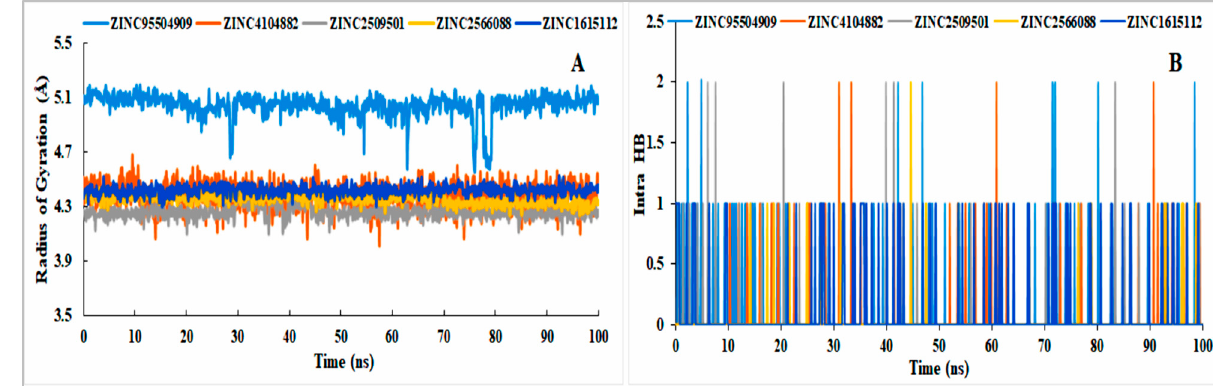
Figure 11. Analysis of the radius of gyration ( A ) and intra-molecular hydrogen bonds ( B ) among the selected ligands and control ligand (ZINC95504909). Different colors mentioned our natural compounds i.e., ZINC4104882 (orange), ZINC2509501 (gray), ZINC2566088 (gold), ZINC1615112 (blue), and control ligand ZINC95504909 (light blue).